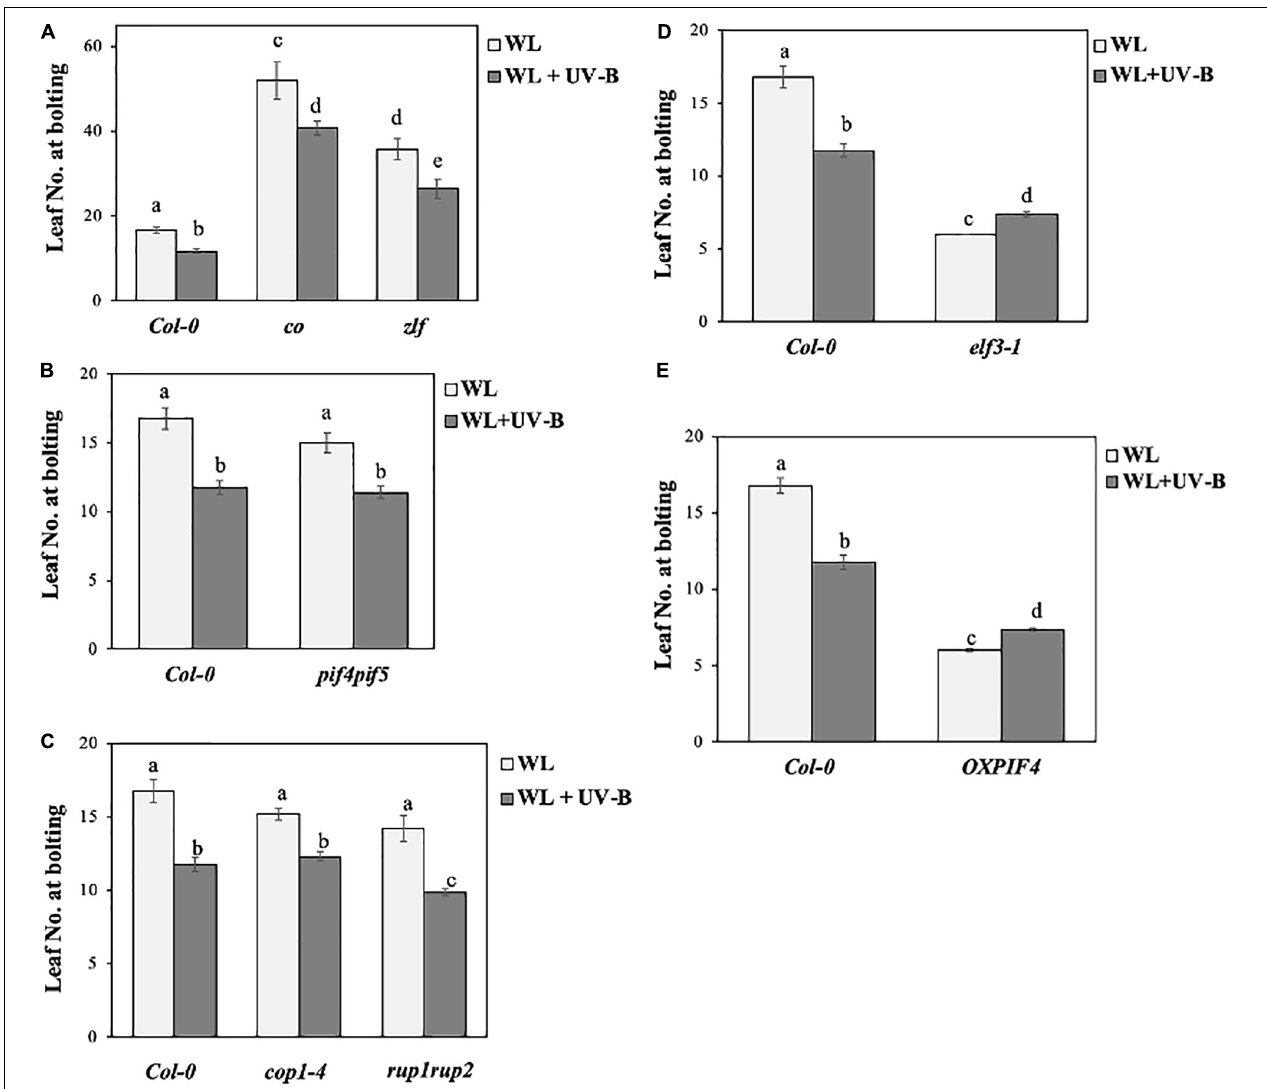
FIGURE 4 | UV-B accelerates flowering of co , zlf , pif4pif5 , cop1-4, and rup1rup2 but delays flowering of elf3-1 and OXPIF4. (A–C) Flowering time of wild-type Col-0 , co and zlf (A) , pif4pif5 (B) , and cop1-4 and rup1rup2 (C) plants grown under a LD photoperiod in WL (50 µ mol m − 2 s − 1 ) or WL supplemented with UV-B (0.5 µ mol m − 2 s − 1 ). Data are represented as mean ± SEM ( n ≥ 15). Different letters indicate statistically significant differences ( P < 0.05) between means. (D,E) Flowering time of wild-type Col-0 , elf3-1 (D) and OXPIF4 (E) plants grown under a LD photoperiod in WL (50 µ mol m − 2 s − 1 ) or WL supplemented with UV-B (0.5 µ mol m − 2 s − 1 ). Data are represented as mean ± SEM ( n ≥ 15). Different letters indicate statistically significant differences ( P < 0.05) between means. Data are representative of three biological repeats including all genotypes represented above, a minimum number of 15 plants was assayed per